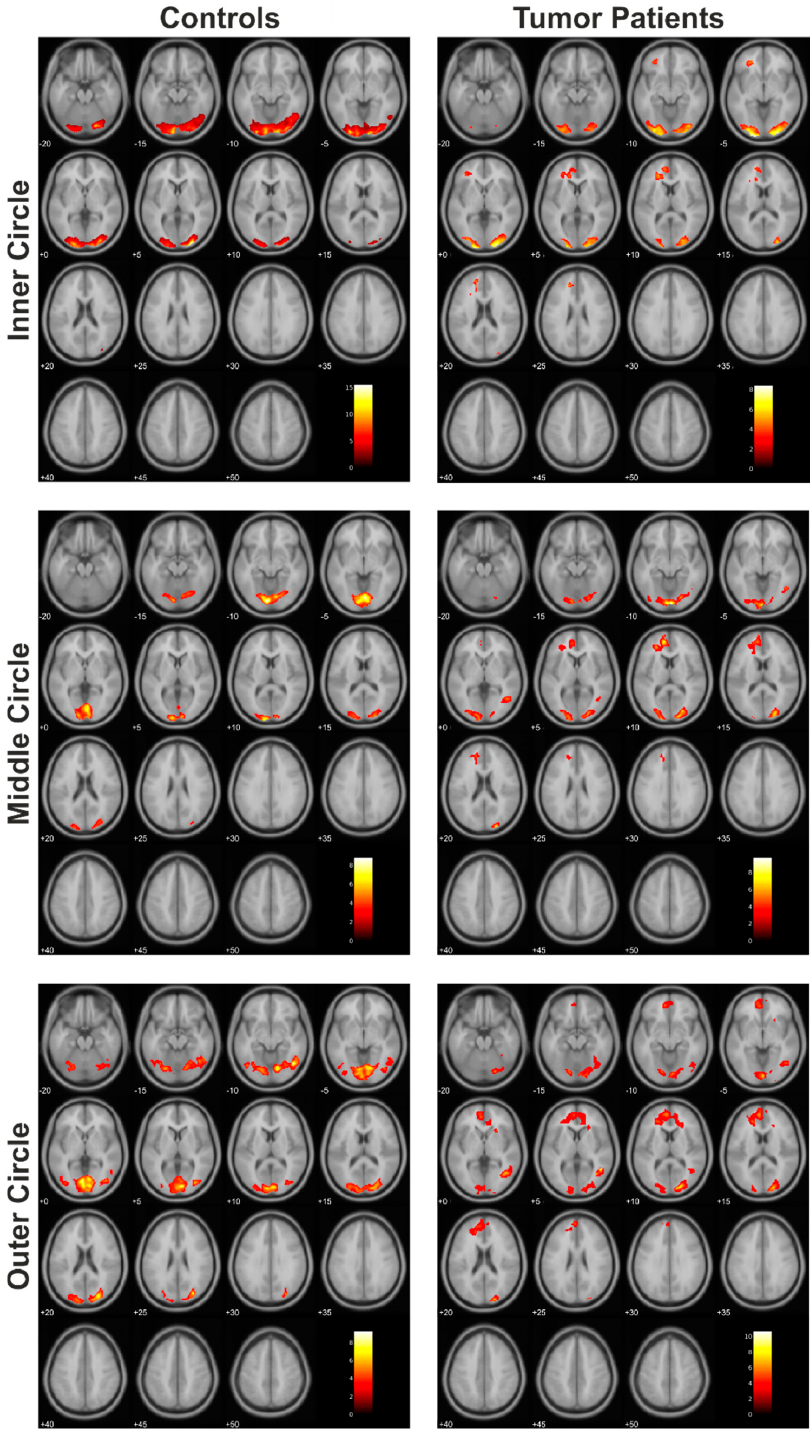
Figure 2. Cortical activation patterns within the control group and tumor patients group (each N = 12).